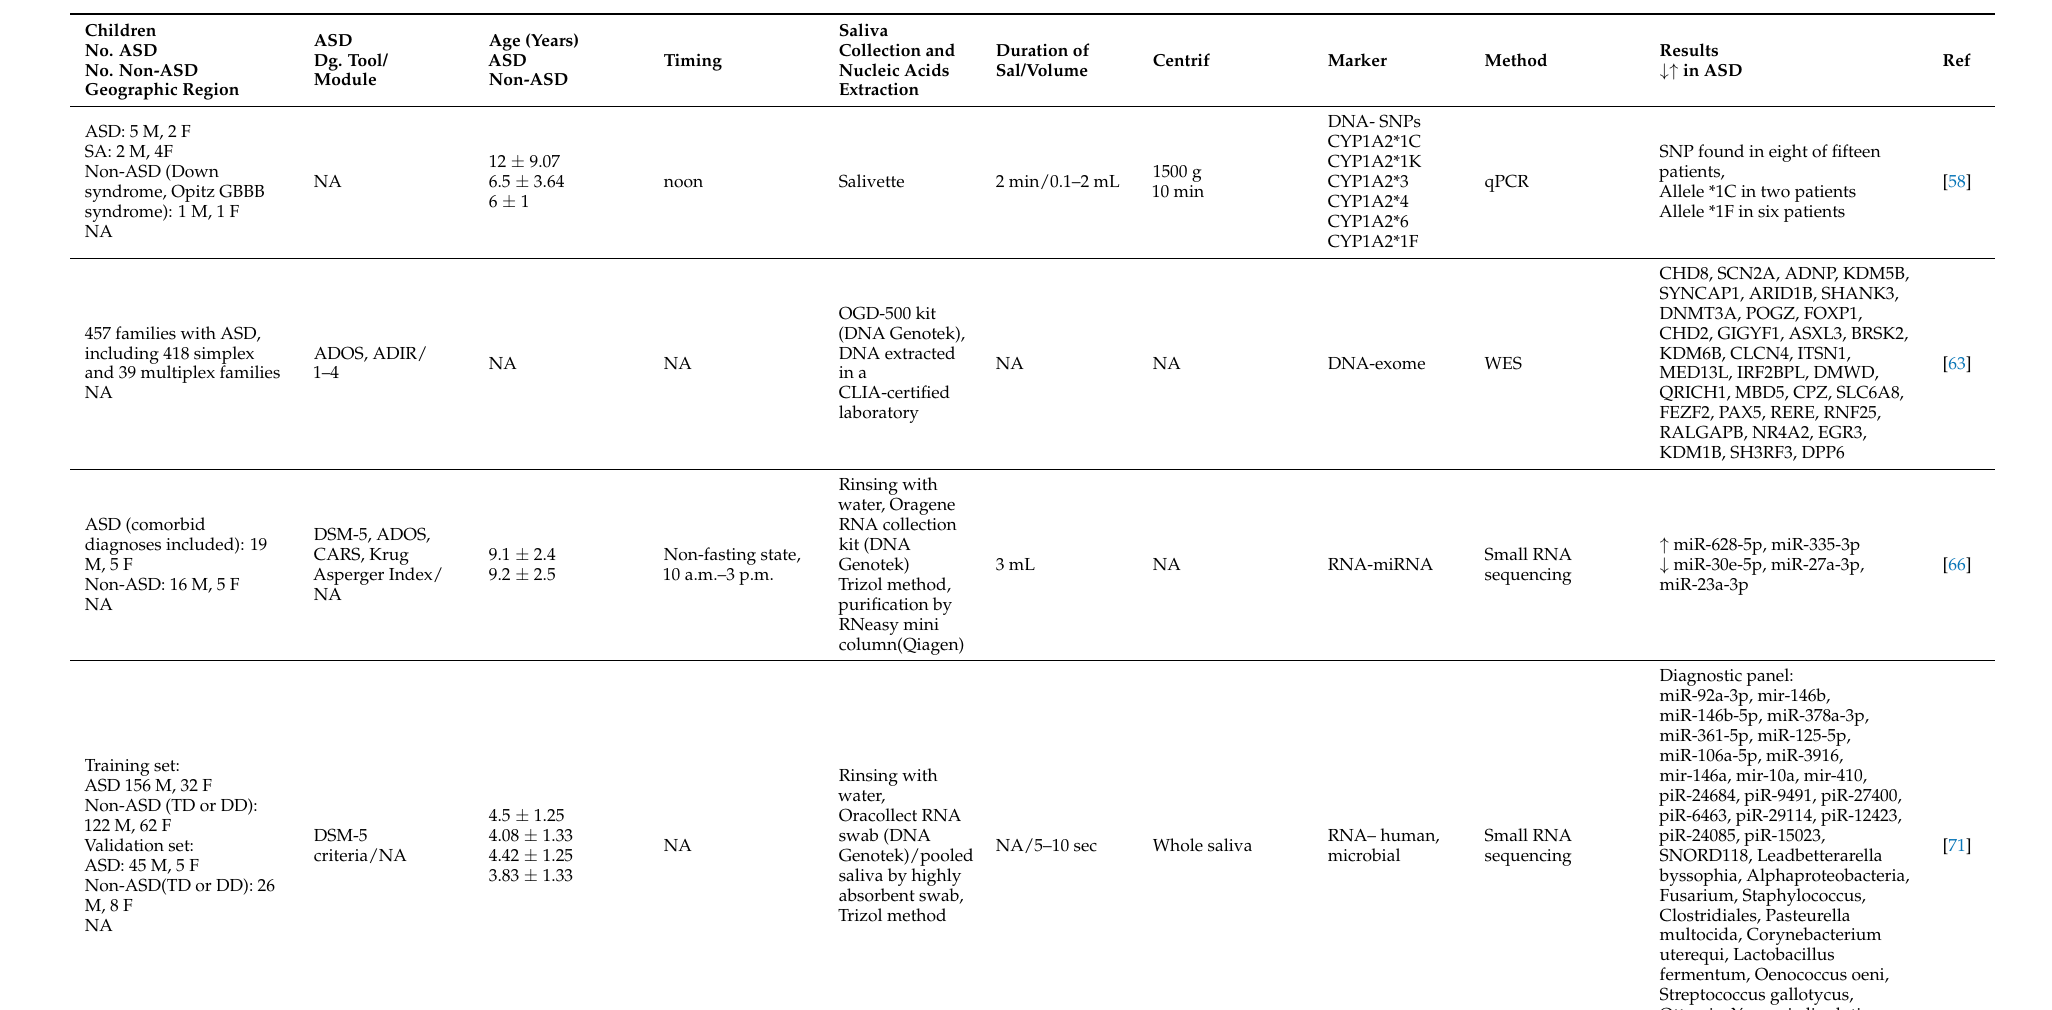
Table 1. Studies focused on salivary nucleic acids in